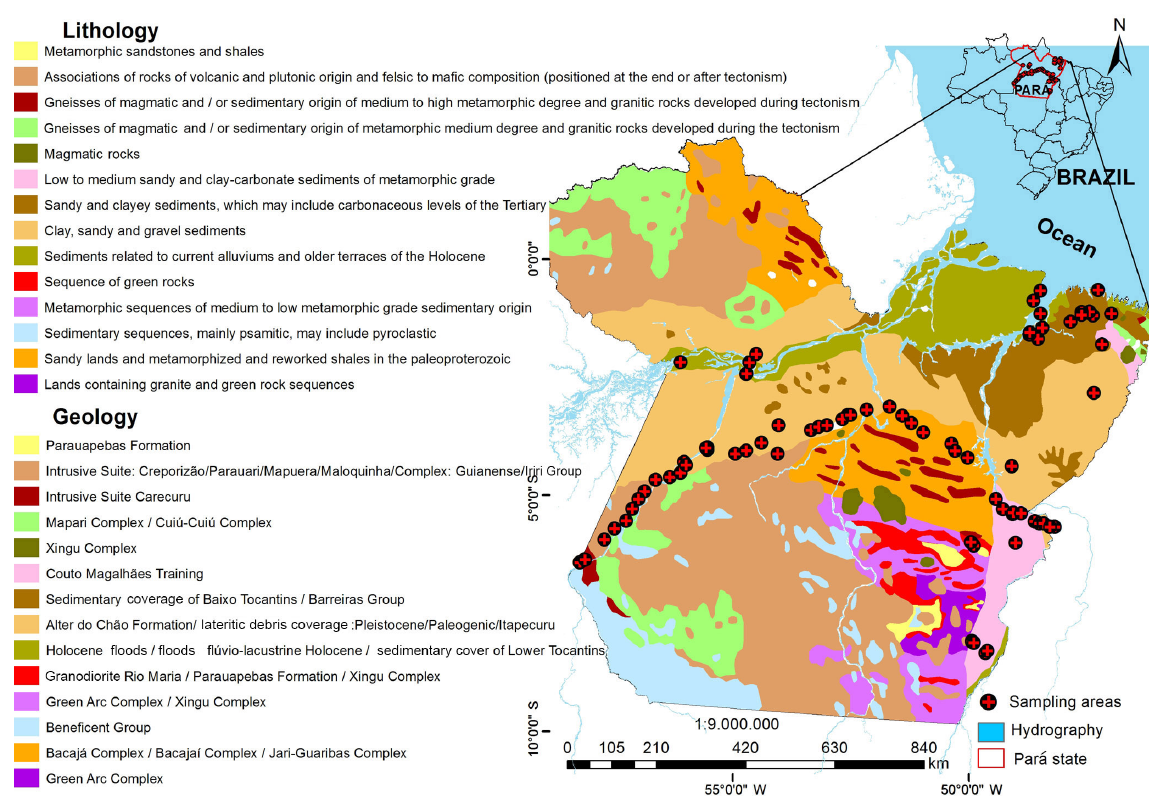
Figure 2. Geological characterization and lithologies of the soils of the state of